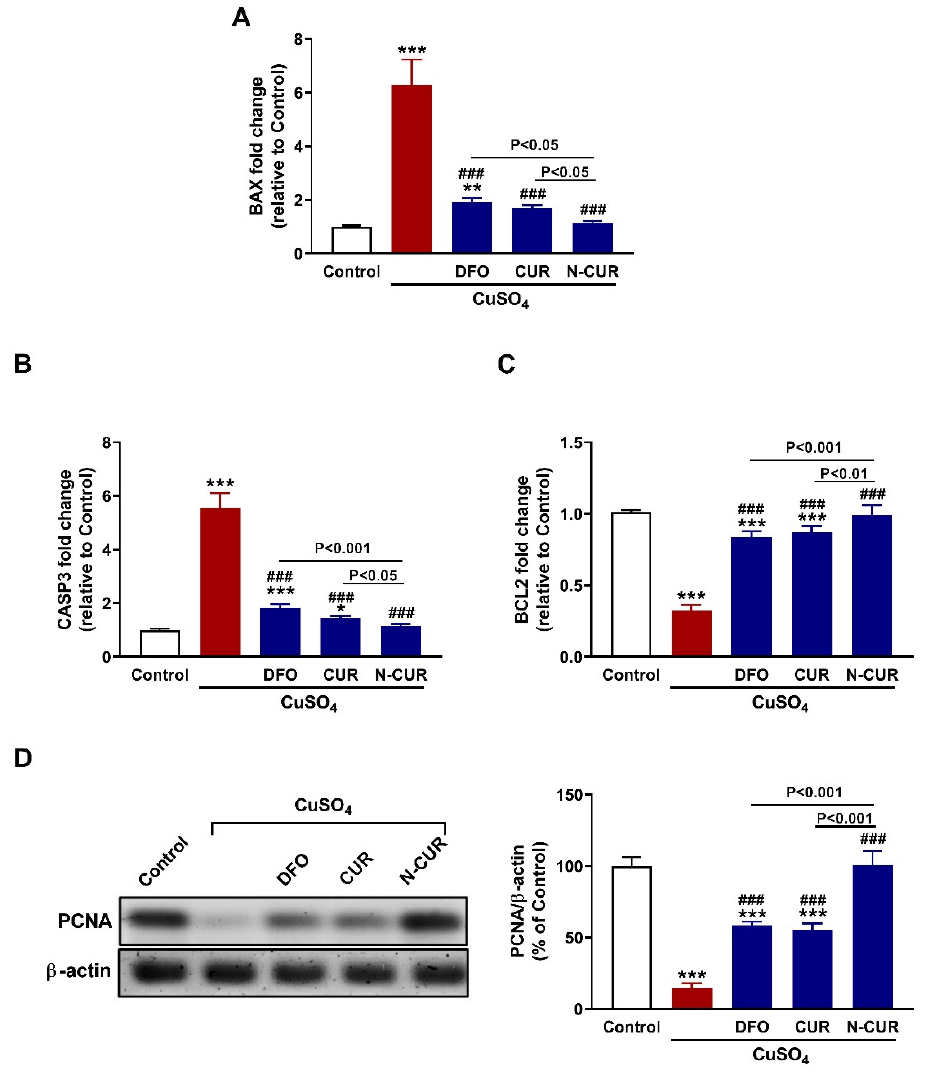
Figure 7. N-CUR and CUR prevent testicular apoptosis in Cu-intoxicated rats. CUR, N-CUR, and DFO downregulated ( A ) Bax and ( B ) caspase-3, and upregulated ( C ) Bcl-2 and ( D ) PCNA in the testis of rats. Data are mean ± SEM, ( n = 8). * p < 0.05, ** p < 0.01 and *** p < 0.001 versus Control, and ### p < 0.001 versus CuSO 4 .